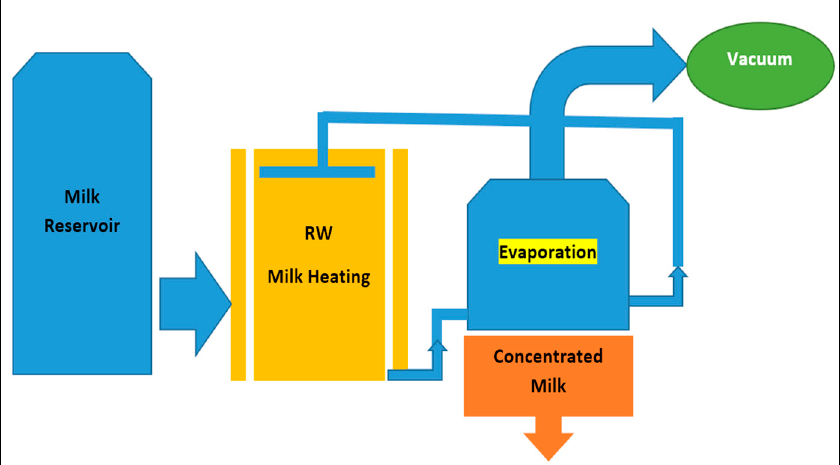
Figure 1. A layout of the locally refractance window milk concentrator and operation.